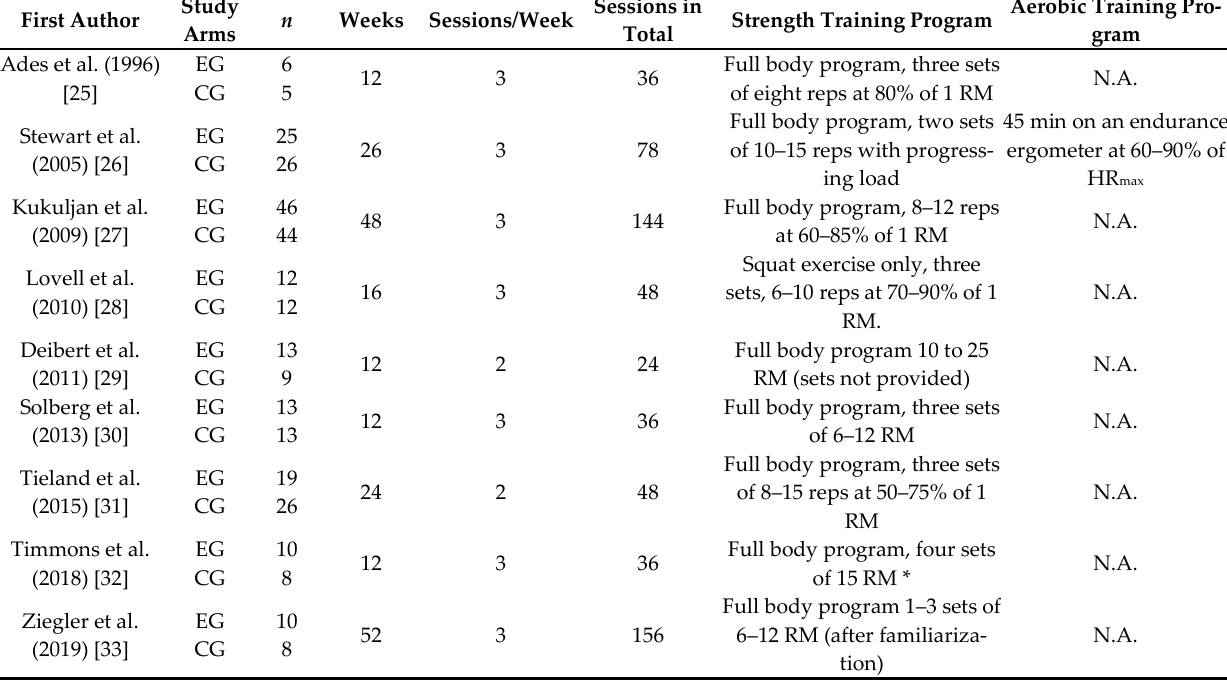
Table 2. Study characteristics in healthy elderly